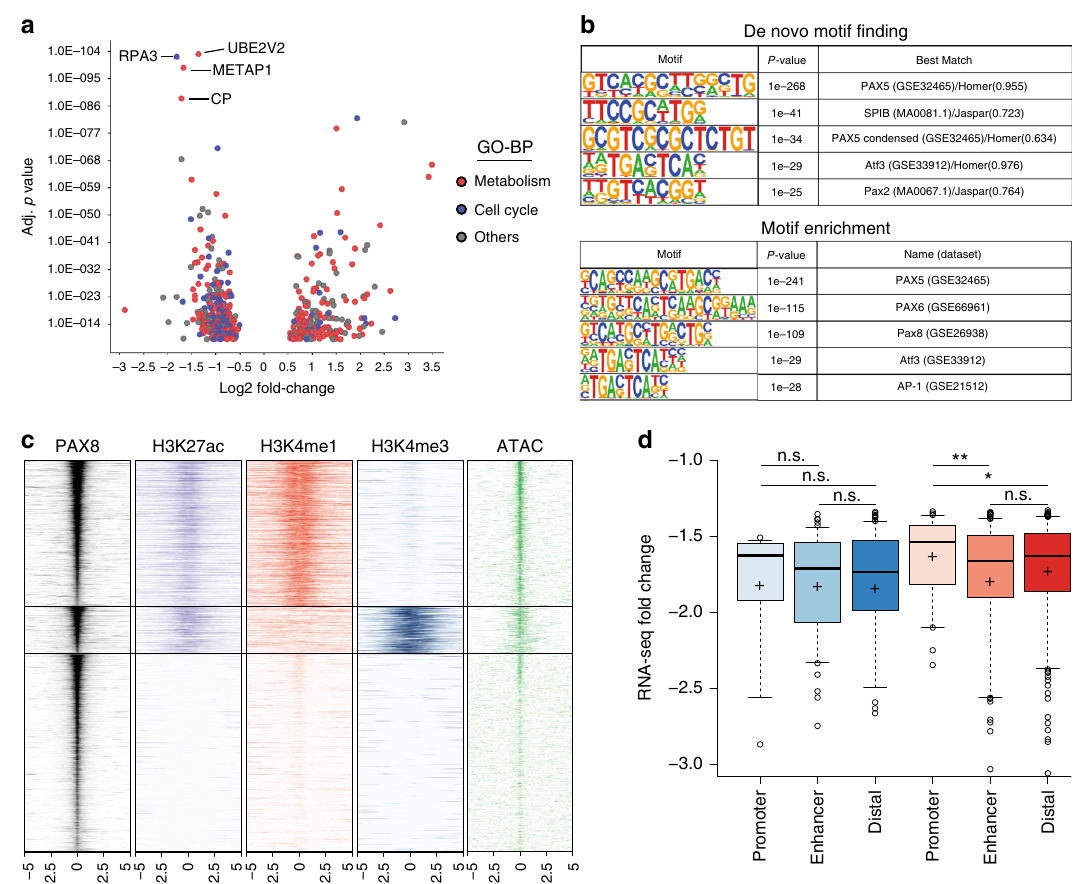
Fig. 2 PAX8 regulates metabolic genes via enhancer elements. a Scatter plot representing the LogFC vs. Adj p -value of genes differentially expressed upon PAX8 knockdown across four RCC cell lines. Dots are color coded based on “ Gene Ontology — Biological process ” annotation of each gene. Blue represent genes involved in cell cycle and red represent genes consolidated from multiple metabolic process categories. b Slogos representation of Motifs enriched in PAX8 peaks by de-novo motif fi nding or motif enrichment. c Heatmap for PAX8, H3K27ac, H3K4me1, H3K4me3 ChIP-seq, and ATAC-seq signal around a 10 Kb window centered on PAX8 peaks. d LogFC as measured by RNA-seq upon PAX8 knockdown for genes positively regulated by PAX8 and categorized by bearing a PAX8 peak in the promoter, enhancer or distal site. Shades of blue represent genes in the category “ Cell cycle ” , while shades of red represent genes in the category “ Metabolism ” as per Fig. 2a. Center lines show the medians and crosses represent the mean; box limits indicate the 25th and 75th percentiles; whiskers extend 1.5 times the interquartile range from the 25th to 75th percentiles, outliers are represented by dots. n = 15, 91, 136, 53, 191, 359 sample points.* p < 0.05 and ** p < 0.01 based on Welch ’ s